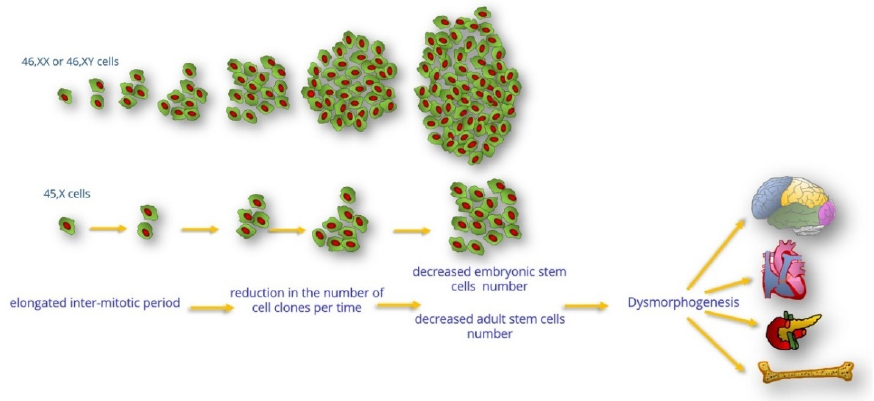
Figure 1. Consequences of the cell cycle duration between euploid and aneuploid cells. Cells with 45,X have a prolonged cell cycle, leading to a reduction in the number of cell clones per unit of time with selective disadvantages in vitro and in vivo.